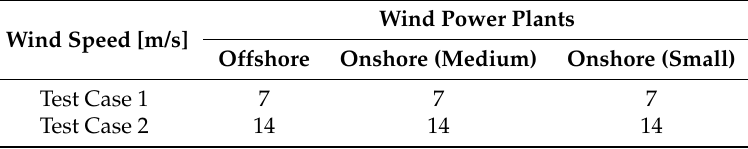
Table 2. Wind Speeds for Test Cases.